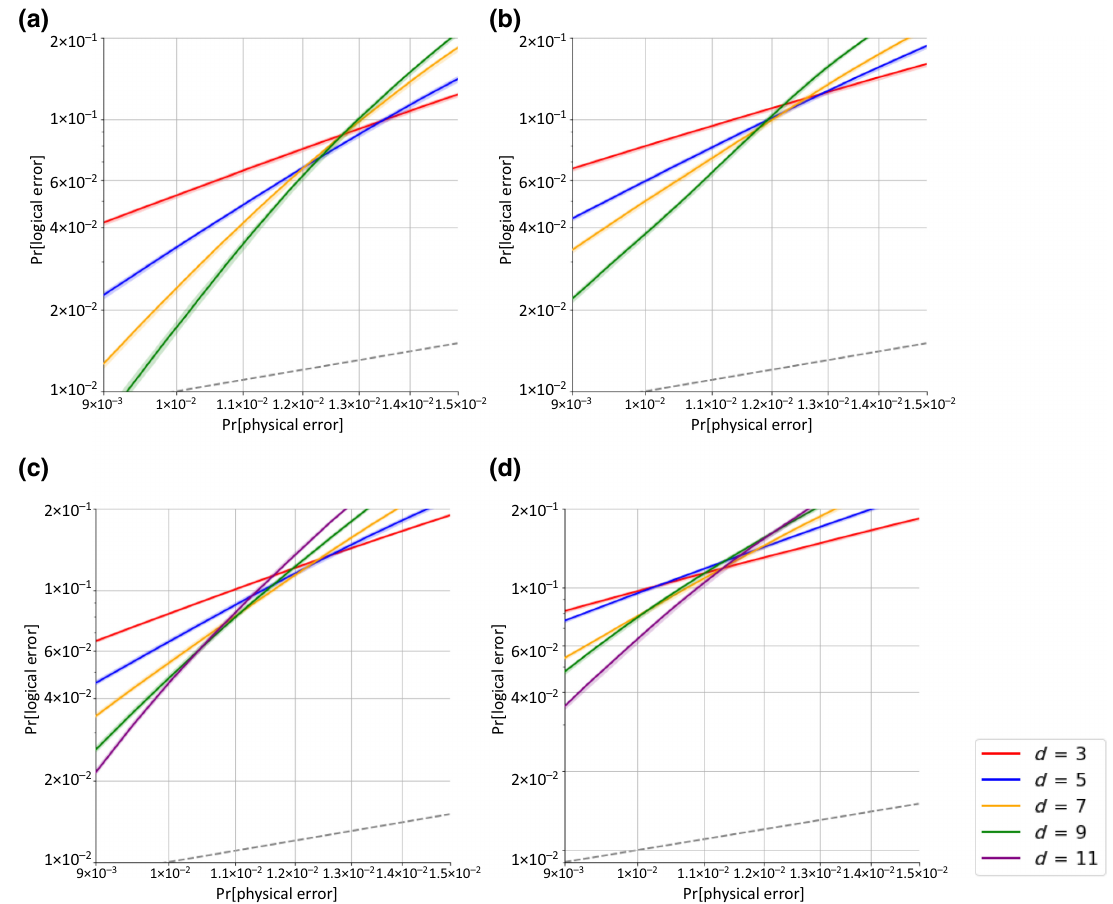
FIG. 7. Logical error rate estimates for the honeycomb and 4.8.8 Floquet codes near threshold: (a) honeycomb torus; (b) honeycomb parallelogram; (c) 4.8.8 torus; (d) 4.8.8 rectangle. In the legend, d is the effective distance of the code. The dashed gray line indicates Pr[logical error] = Pr[physical